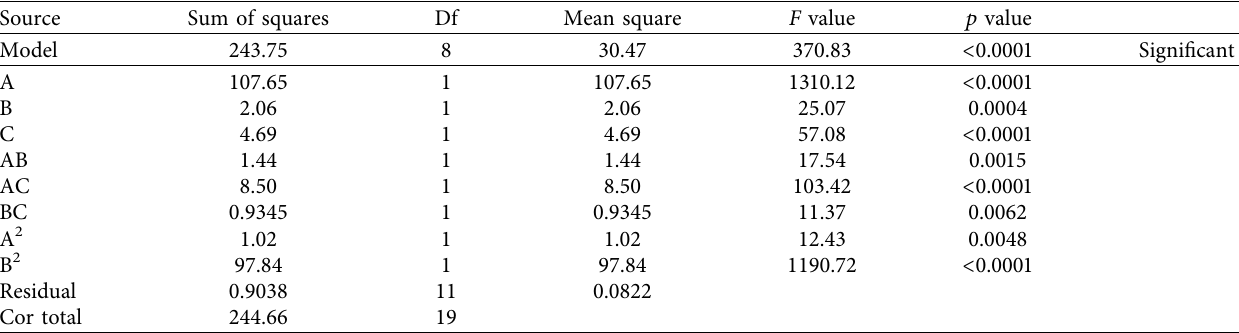
Table 8: Analysis of variance (ANOVA).